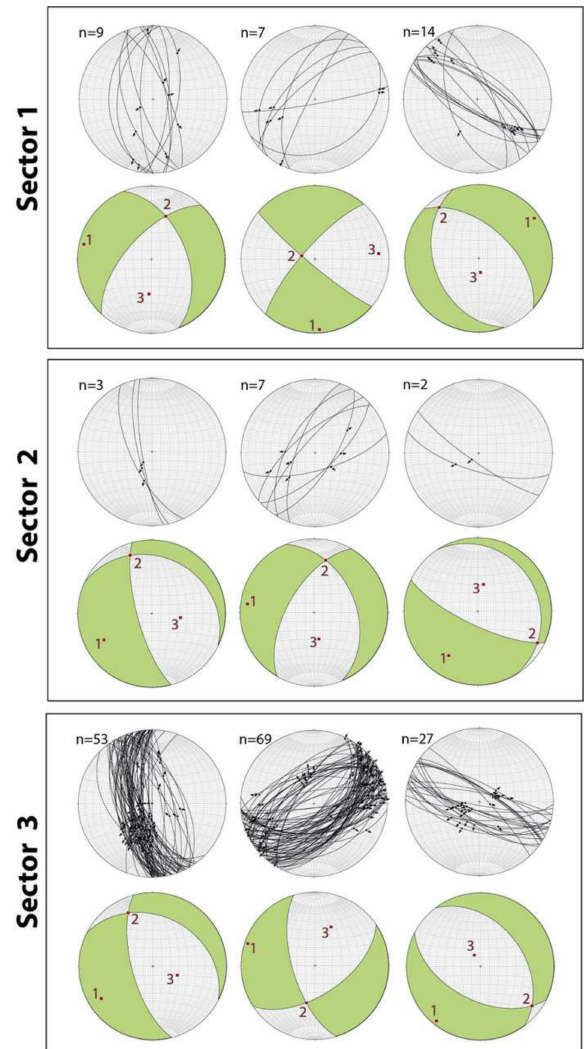
Figure 8. Stereographic diagrams (equiareal diagrams, lower hemisphere) illustrating cumulative kinematic data collected in different structural stations and divided per fault systems: N-S, NW- and NE-striking faults. For each fault system, faults and striae (upper diagrams) and fault plane solutions diagrams with kinematic axes from the inversion of kinematic data are shown. Location of the indicated sectors are reported in Figure 3. Kinematics data from area 1 have been integrated with those published in [38]; Kinematics data from area 3 have been integrated with those published in